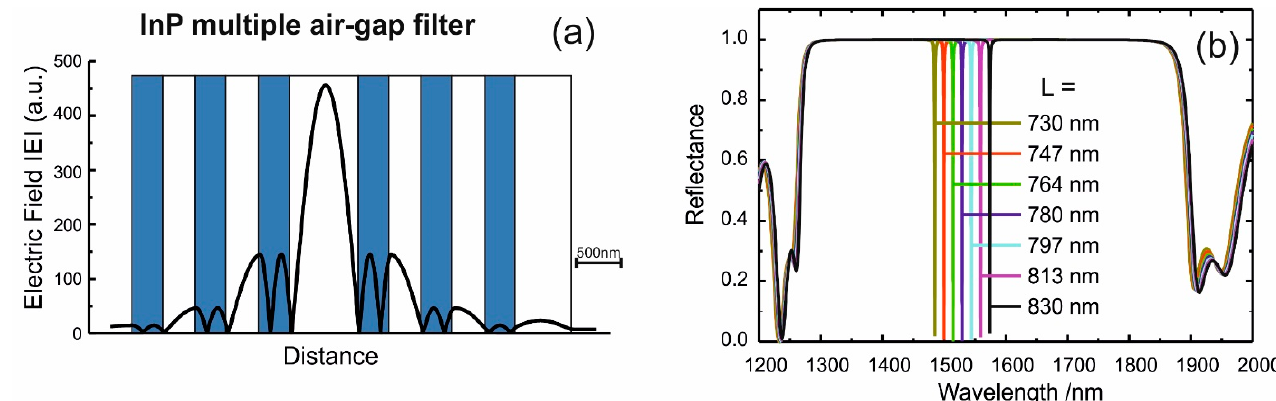
Figure 12. MEMS tunable InP multiple air-gap FP filter with half-a-wavelength central cavity. ( a ) Cross section of an InP multiple air-gap FP filter including the larger central air-gap of width L . The absolute value of the standing electrical field is displayed in black. ( b ) Corresponding reflectance spectra for different central air-gap widths L , which is obtained by MEMS tuning. In this case only L is varied, all the λ /4 air-gaps remain unchanged.